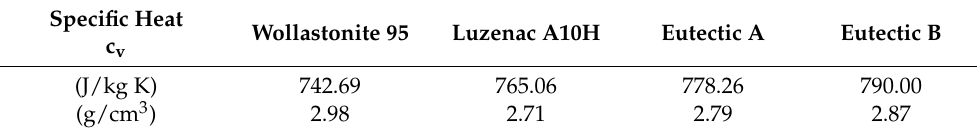
Table 3. Calculated average specific heat c v and density ρ of used